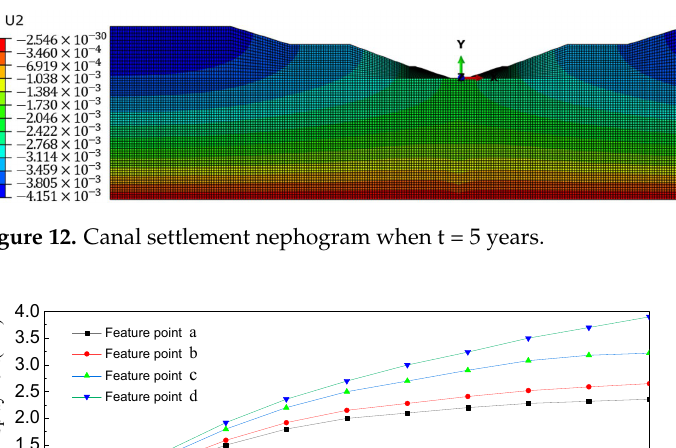
Figure 11. Canal pore pressure contour when t = 20 years.